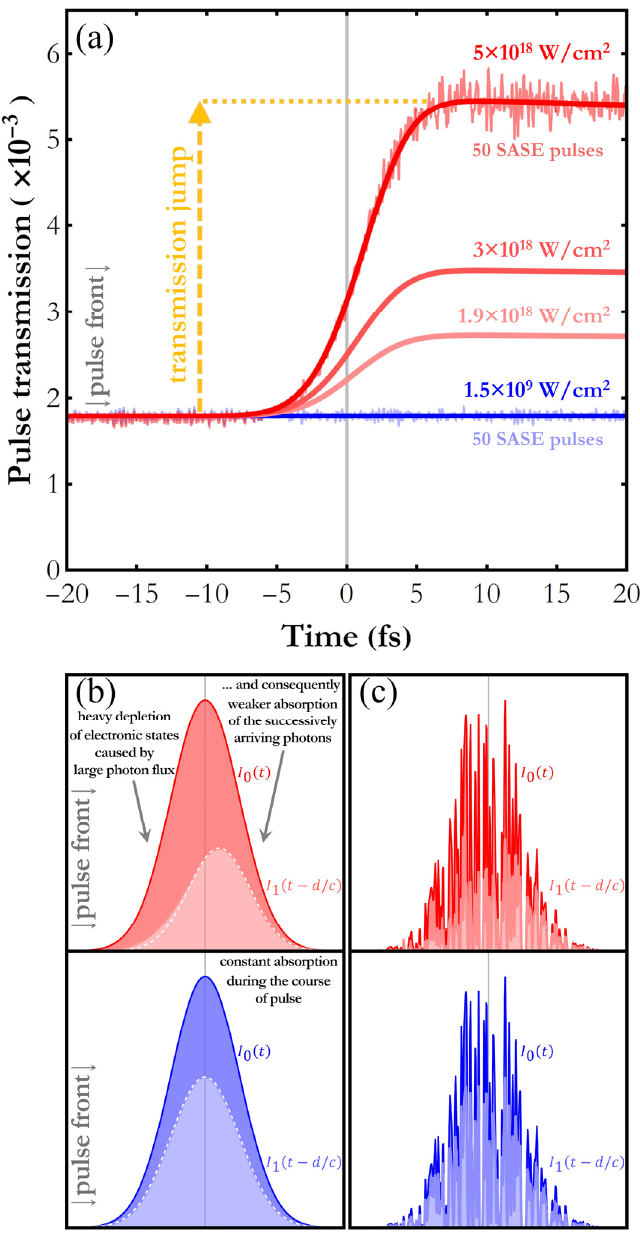
Figure 3. ( a ) Temporal evolution of transmission simulated for low- (blue) and high-intensity (red) pulses of 7130 eV photons through a 20 µ m thick Fe foil. Ratio I 1 ( t − d / c ) / I 0 ( t ) of time distribu- tions of the transmitted pulse I 1 ( t ) = I ( x = d, t ) and of the incident pulse I 0 ( t ) = I ( x = 0 µ m, t ) , with the target thickness d and the speed of light c , for different incident pulse average intensities I 0 ( t ) × 7130 eV. The plotted ratio shows the effect of pulse-target interaction on photon time dis- tribution around the temporal center of mass of the incident pulse, hence the subtraction t − d / c . ( b ) Gaussian-like time envelopes I 0 ( t ) and I 1 ( t − d / c ) (not to scale) for low intensity (blue) and high intensity (red). Gaussian shape is delineated with the white dashed line. The transmitted pulse time envelope is shifted in time phase and loses the original Gaussian shape. ( c ) SASE-like time envelopes I 0 ( t ) and I 1 ( t − d / c ) (not to scale) for low intensity (blue) and high intensity